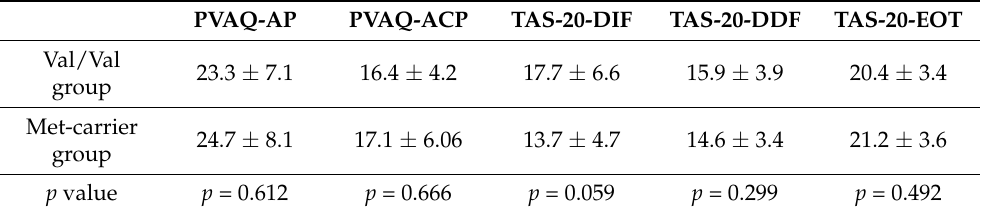
Table 1. Scores obtained on each subscale of PVAQ and TAS in each COMT group.